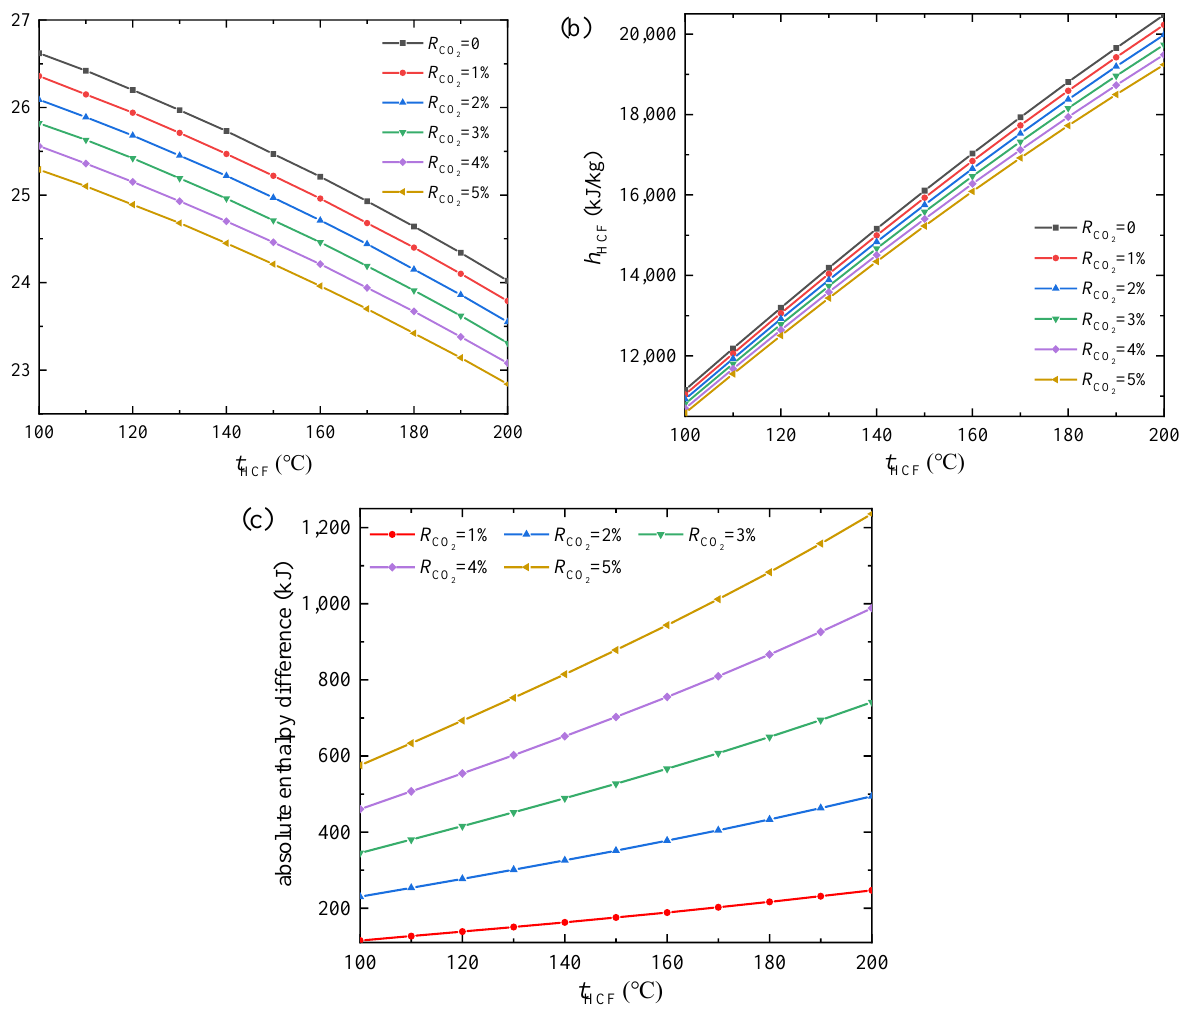
Figure 5. Variation curves of productivity parameters of heat carrier with t HCF under different R CO2 : ( a ) mass flow rate, ( b ) enthalpy and ( c ) absolute enthalpy difference. The enthalpy of the heat-carrying fluid at the wellhead is positively correlated with temperature, while it is negatively correlated with R CO2 , which can be seen in Figure